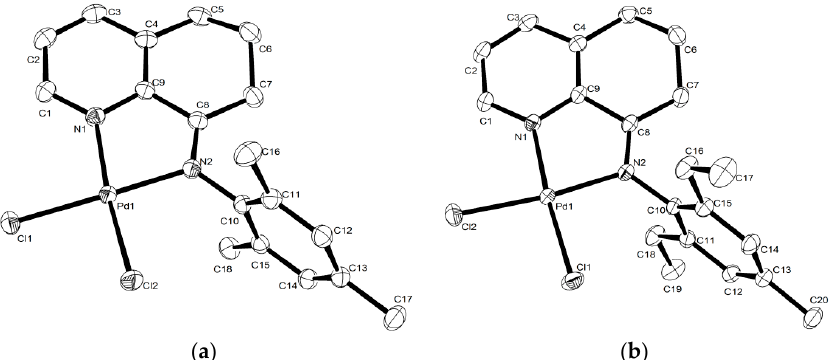
Figure 2. ORTEP diagrams of Pd4 ( a ) and Pd5 ( b ). Thermal ellipsoids set at the 30% probability level. Hydrogen atoms are omitted for clarity.